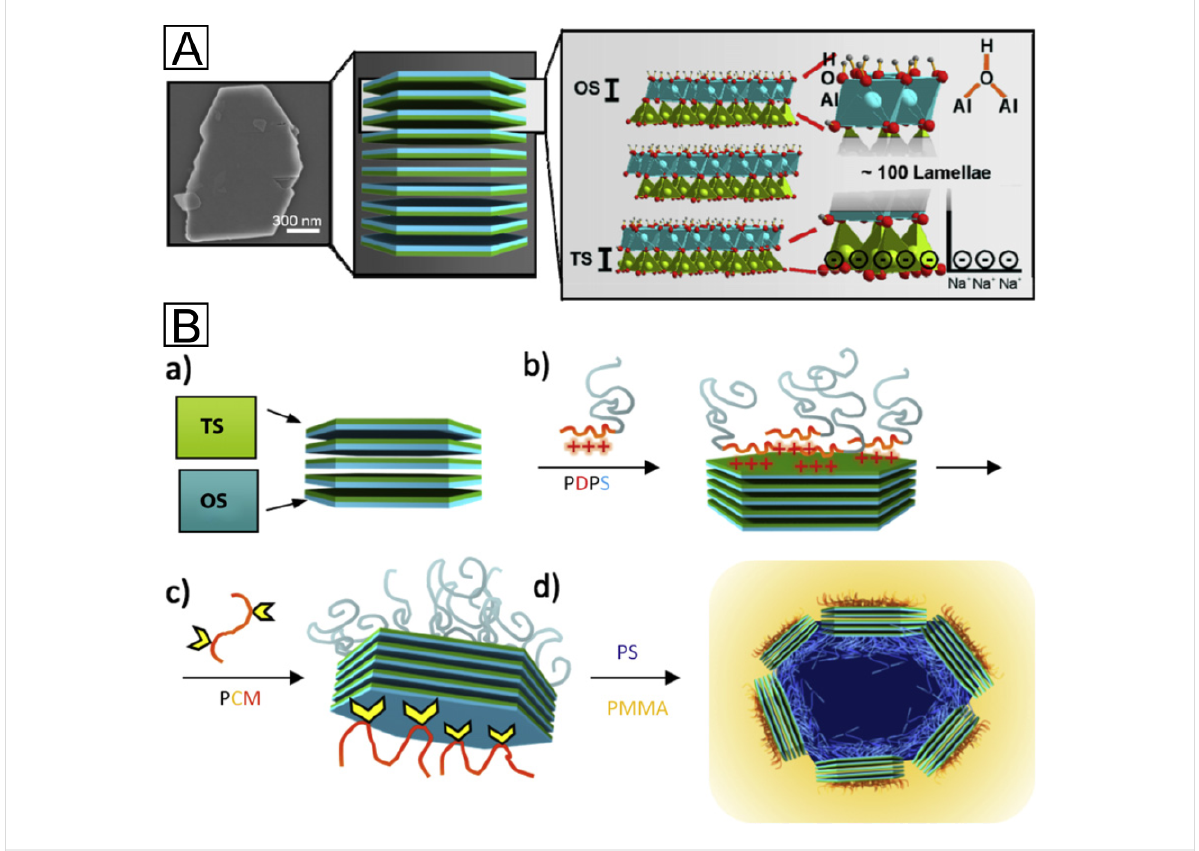
Figure 5: (A) SEM top view image of a typical kaolinite platelet (left), schematic picture of kaolinite platelets (centre), and crystal structure of three kaolinite lamellae with the specific chemical functions at the basal TS and OS (right). (B) Schematic picture of a) pristine kaolinite, b) modified with PDPS on the tetrahedral surface (TS), c) further modified with PCM on the opposite octahedral surface (OS), and d) embedding of the final hybrid particle at the interface in a PS-PMMA blend. Reprinted with permission from [34]. Copyright 2013